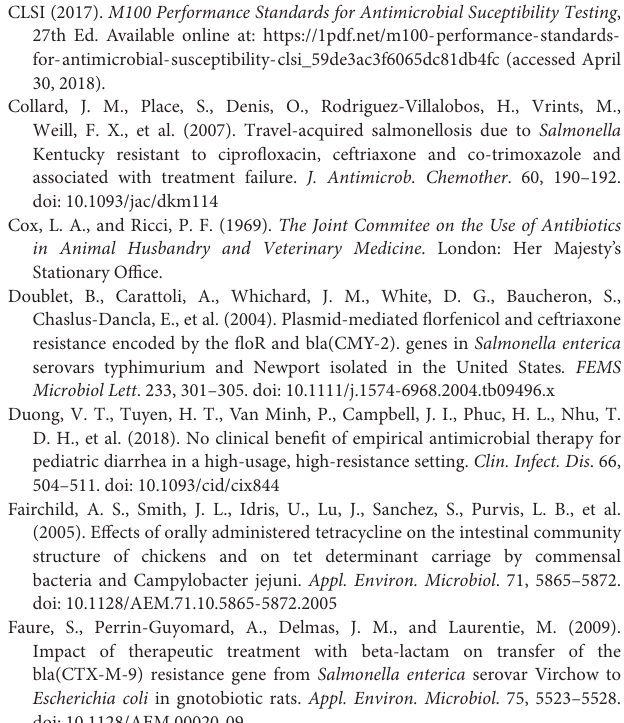
Supplemental Figure 2 | Pulsed-field gel electrophoresis (PFGE Xba I) confirms antibiotic-resistant Salmonella recovered from the poultry environment as the S. Typhimurium strain administered to the birds as isolates 934R and 3147. Lanes 1 and 16: MW DNA standard Saccharomyces cerevisiae chromosomes; Lane